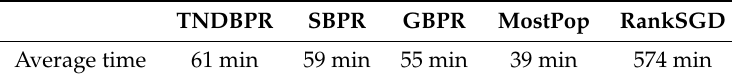
Table 4. Average execution time on Epinions